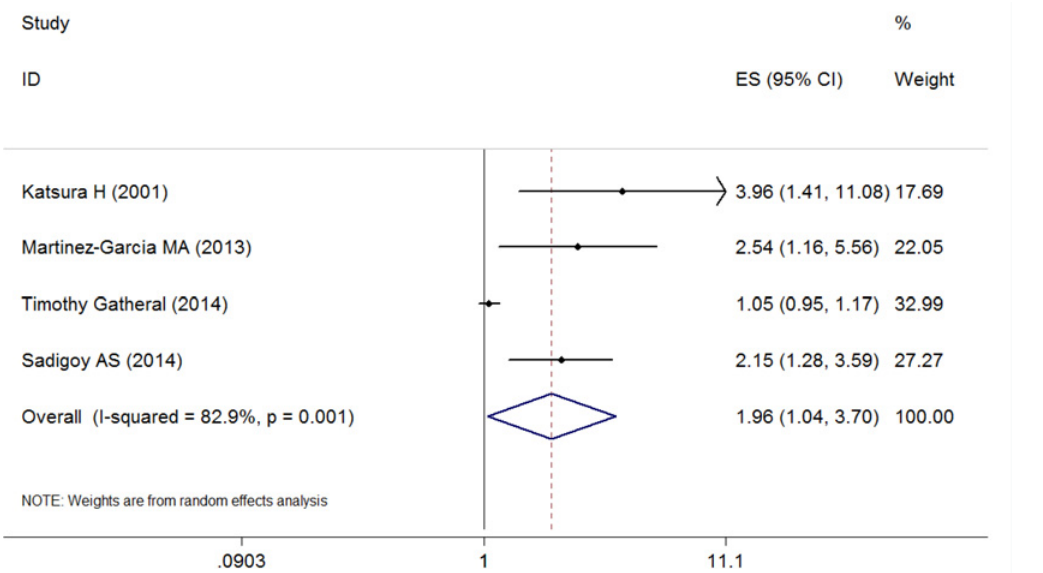
Fig 5. Odd ratios for the association between comorbid bronchiectasis and risk for mortality.